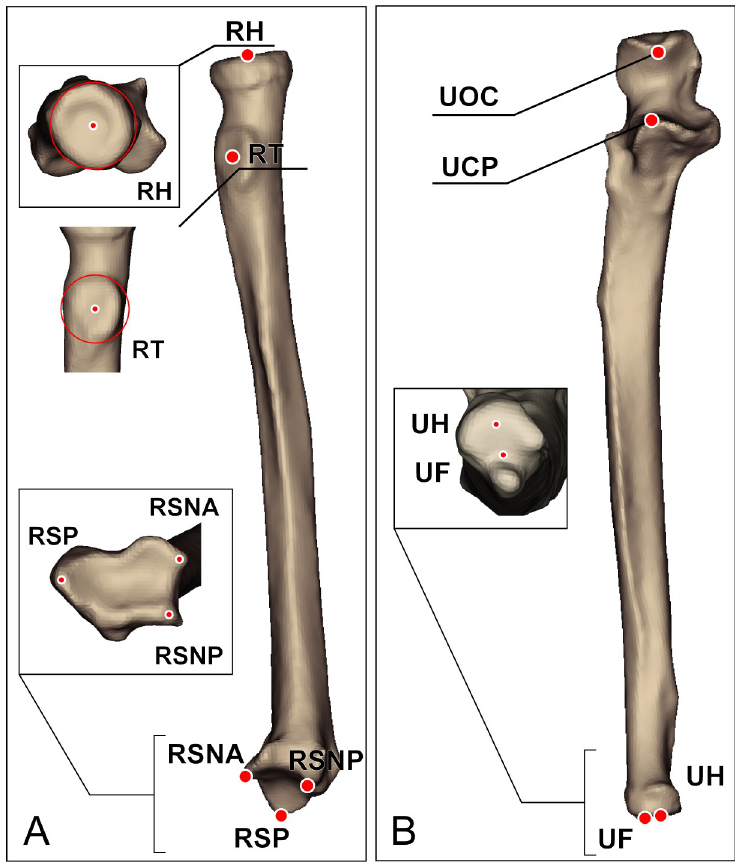
Fig 3. Landmark points on the forearm bones. (A) RH , the radial head; RT , the radial tuberosity; RSP , the radial styloid process; RUNA , ulnar notch anterior lip of the radius; RUNP , ulnar notch posterior lip of the radius. (B) UOC , olecranon tip of the ulna; UCP , coronoid process of the ulna; UF , the ulnar fovea; UH , the ulnar head. B. Bowing. The length of right coronal bowing of females was 171.38 ± 10.55 mm and the left was 170.01 ± 10.63 mm (P = 0.510). The location of bowing in the coronal plane was 96.67 ± 13.84 mm in the right female radius, and the left was 96.67 ± 9.49 mm (P = 0.900). The coronal bowing depth of the right female radius was 10.45 ± 2.08 mm, and 10.38 ± 1.77 mm in the left (P = 0.854). In males, the length of the right radial bowing was 184.83 ± 9.77 mm, and the left was 183.29 ± 9.87 mm (P = 0.359). The coronal bowing location of the right male radius was 104.43 ± 9.65 mm, and that of the left was 102.56 ± 9.31 mm (P = 0.248). The coro- nal bowing depth of the right male radius was 11.95 ± 1.85 mm, and that of the left was 12.15 ± 1.90 mm (P = 0.533). The measured length of sagittal bowing in females was 171.92 ± 10.39 mm on the right side, and 170.92 ± 10.45 mm on the left (P = 0.623). Sagittal bowing in females was located at 111.67 ± 23.08 mm for the right, and 104.81 ± 22.26 mm for the left (P = 0.126). The bowing location in the sagittal plane of females was 7.76 ± 2.93 mm for the right, and 7.93 ± 3.01 mm for the left (P = 0.770). In males, right sagittal bowing was located at 183.87 ± 10.76 mm, and left at 182.53 ± 9.44 mm (P = 0.439). The bowing location in the sagittal plane of male was located in 119.02 ± 25.96 mm for the right, and the left was 118.91 ± 24.52 mm (P = 0.980). Sagittal depth was 9.99 ± 3.07 mm and 10.02 ± 3.40 mm for the right and left, respectively (P = 0.956).